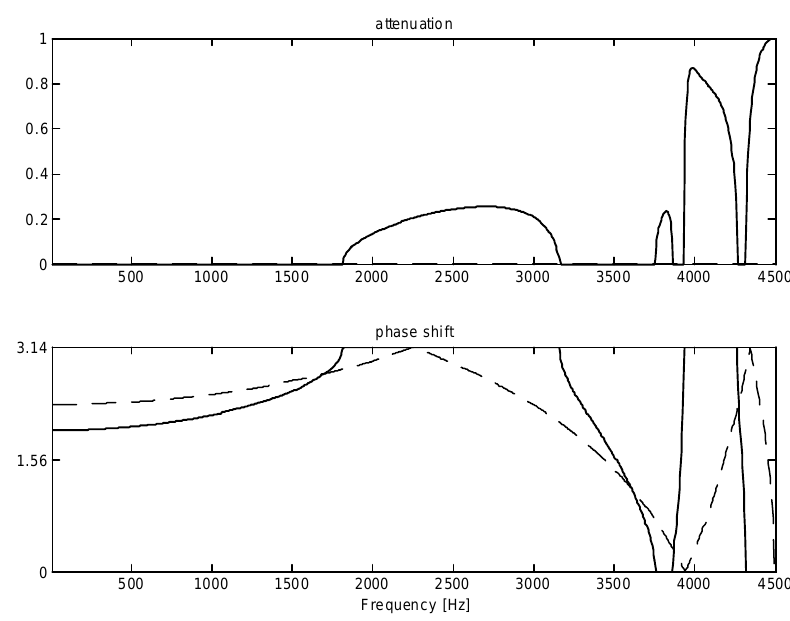
Fig. 14. Propagation characteristics of a periodic tapered shell type